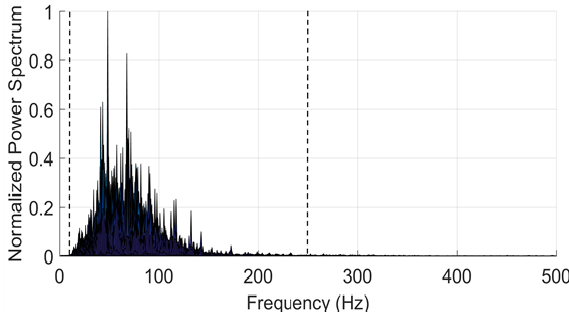
Figure 1. Sketch of the power spectrum of a typical raw electromyography (EMG) signal.